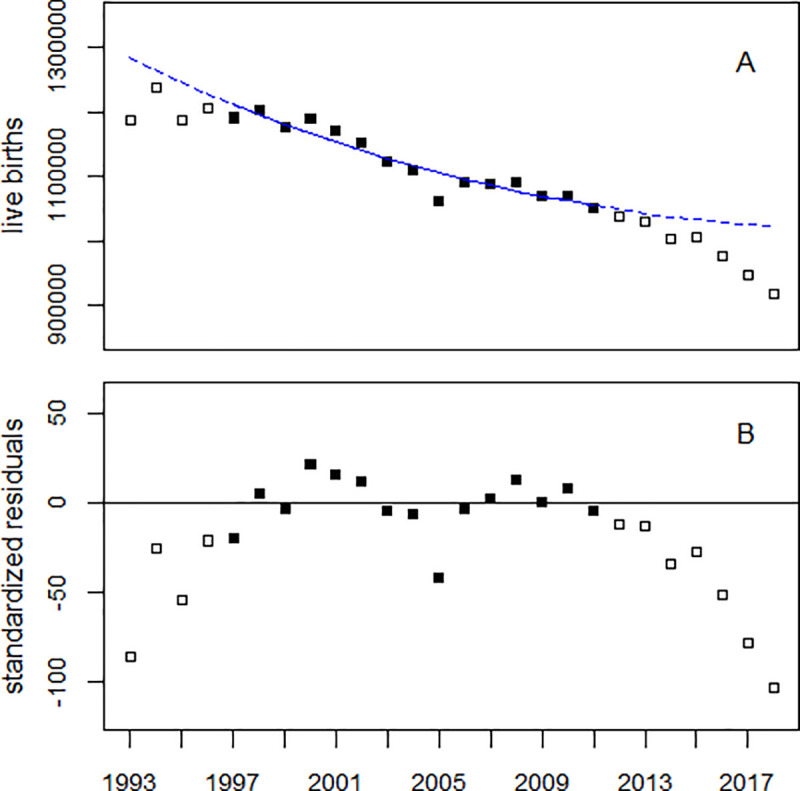
Panel A: Monthly numbers of LB from Japan, 1993–2018, and result of a Poisson regression of the data from 1997 to 2011 (black dots) with a linear-quadratic time trend. The broken line shows the extrapolated trend line. Panel B: Deviations of the observed numbers from the predicted trend in units of standard deviations (standardized residuals).